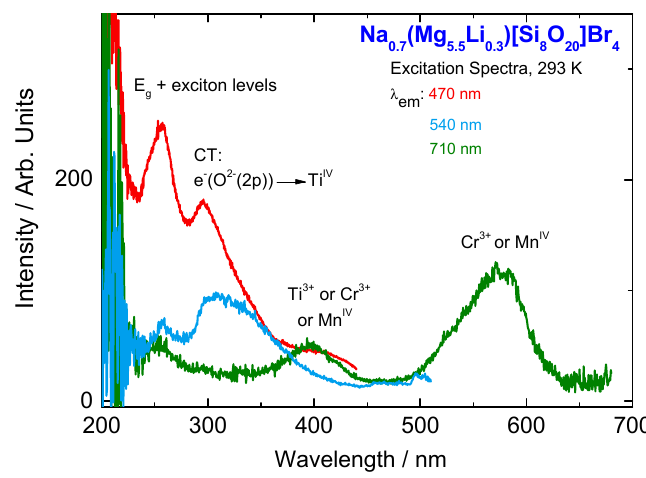
Figure A7. Excitation spectra of bromohectorite recorded at several emission wavelengths. The data are not corrected for the detector sensitivity at different emission wavelengths.